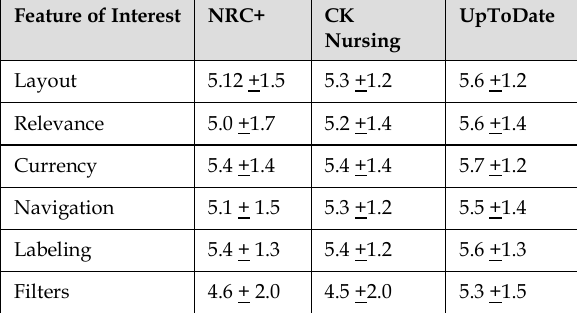
Table 2 Perceptions of PoCT features and characteristics. Mean and standard deviation for each PoCT are reported.